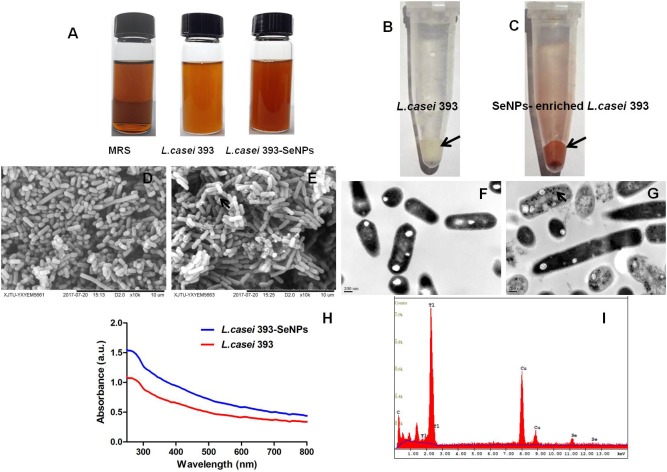
Preparation and characterization of selenium nanoparticles (SeNPs)-enriched L. casei 393. (A) Appearance of MRS or L. casei 393 cultivated with or without Na2SeO3 at 30°C for 24 h. (B) Visible white color of L. casei 393. (C)
L. casei 393-SeNPs appear distinct bright red color. (D) SEM images of L. casei 393. (E) SEM images of L. casei 393-SeNPs. (F) TEM image of L. casei 393. (G) TEM image of L. casei 393-SeNPs. (H) Ultraviolet–visible (UV–Vis) absorption spectrum of L. casei 393-SeNPs and L. casei 393. (I) EDX image of L. casei 393-SeNPs.